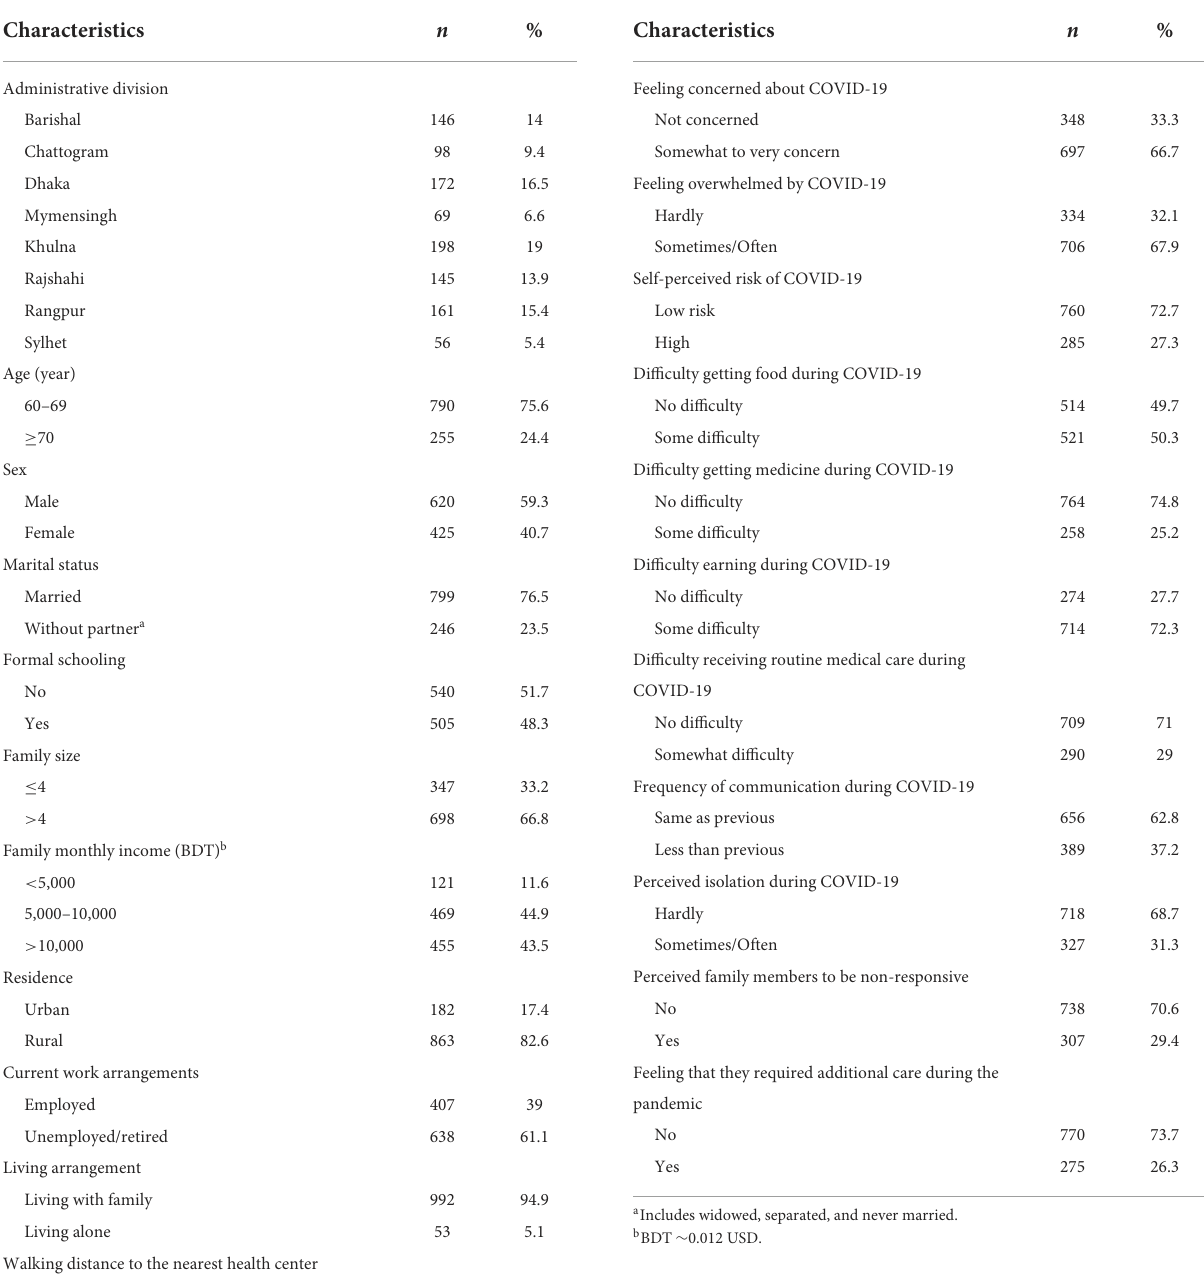
TABLE 1 Characteristics of the participants ( N =